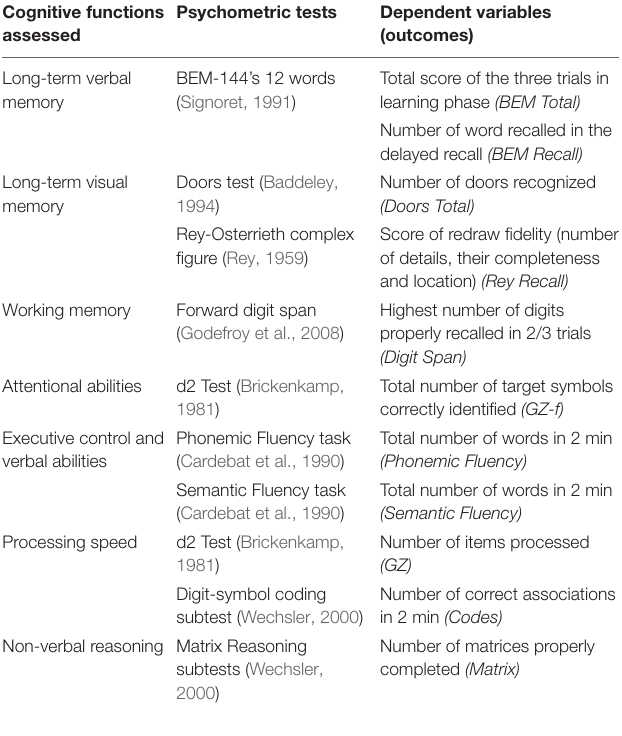
TABLE 3 | Description of the tests and the dependent variables used in the